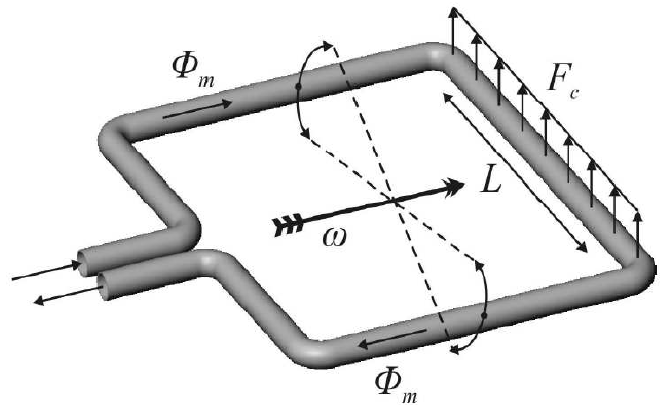
Figure 2. Rectangular shaped Coriolis flow sensor. The tube is brought into resonance by Lorentz actuation at an angular velocity, ω , the displacement at the corners of the tube is between 1 and 10 µm; F indicates the Coriolis force as a result of mass flow Φ c the part of the tube indicated by L; this force causes a displacement of roughly between 1 and 100 nm.